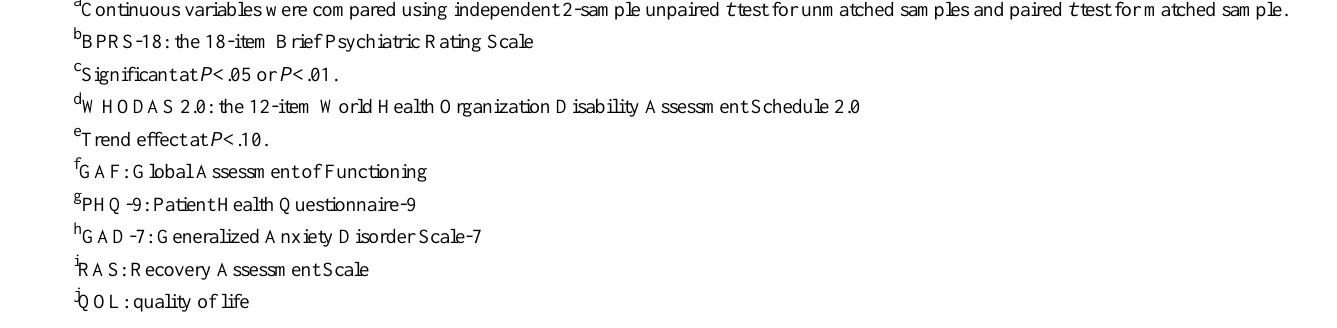
matching)Non-use matched group (D) (N=163), mean